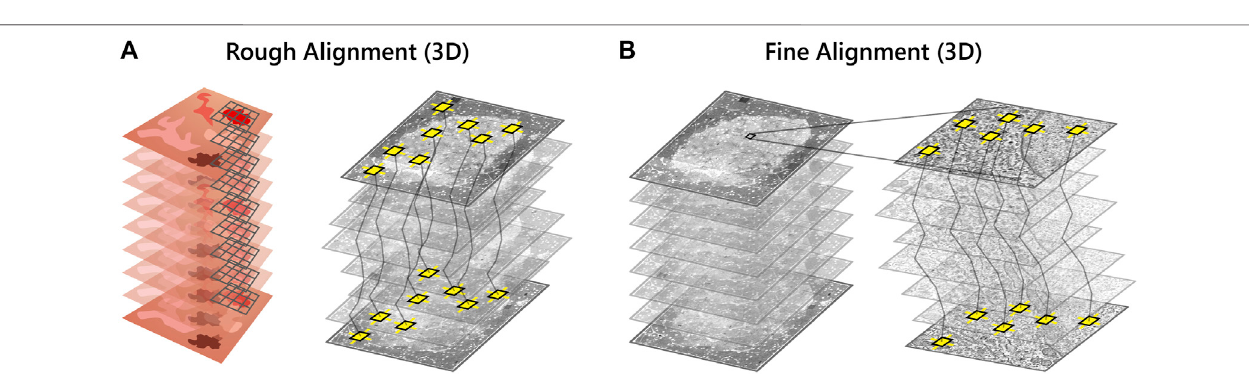
FIGURE4| Volumereconstructionofthehigh-magni fi cationEMstack. (A) SIFTfeatures(yellowsquares)areusedtoroughlyalignthehigh-magni fi cationEMstack in z .AdownsampledimageofeachsectionisrenderedasthefullresolutionEMtilesetistoolarge(severalGB)forfeatureextraction. (B) TheEMstackalignmentisre fi ned by least squares optimization of the displacement between matched features.